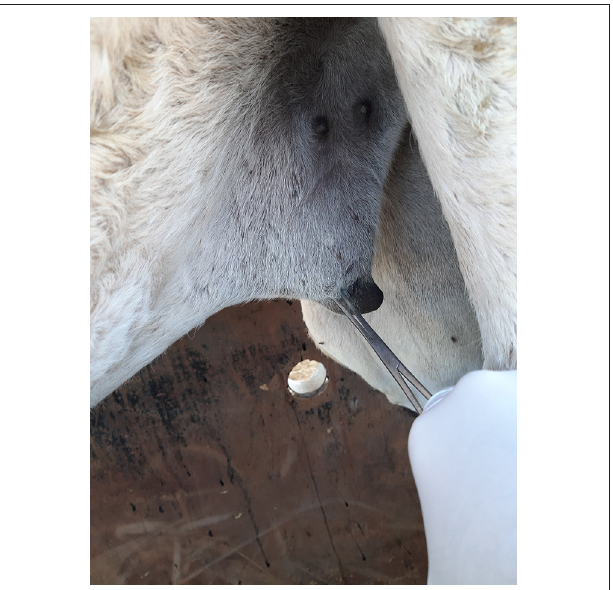
RO (6.67 ± 0.33 min), respectively. The duration of perineal anti- nociception is significantly different between the RO, RO LD and LD groups ( P < 0.001) and being longer in RO and ROLD (158.33 ± 4.01 and 165 ± 3.87 mins, respectively) in comparison with LD (75.83 ± 3.27) ( Table 2